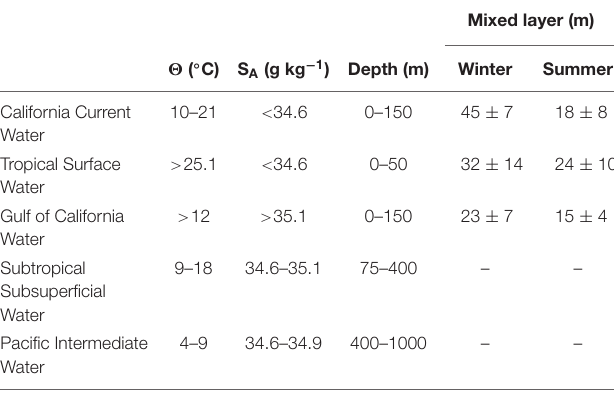
TABLE 1 | Water mass limits in the Tropical Pacific in front of